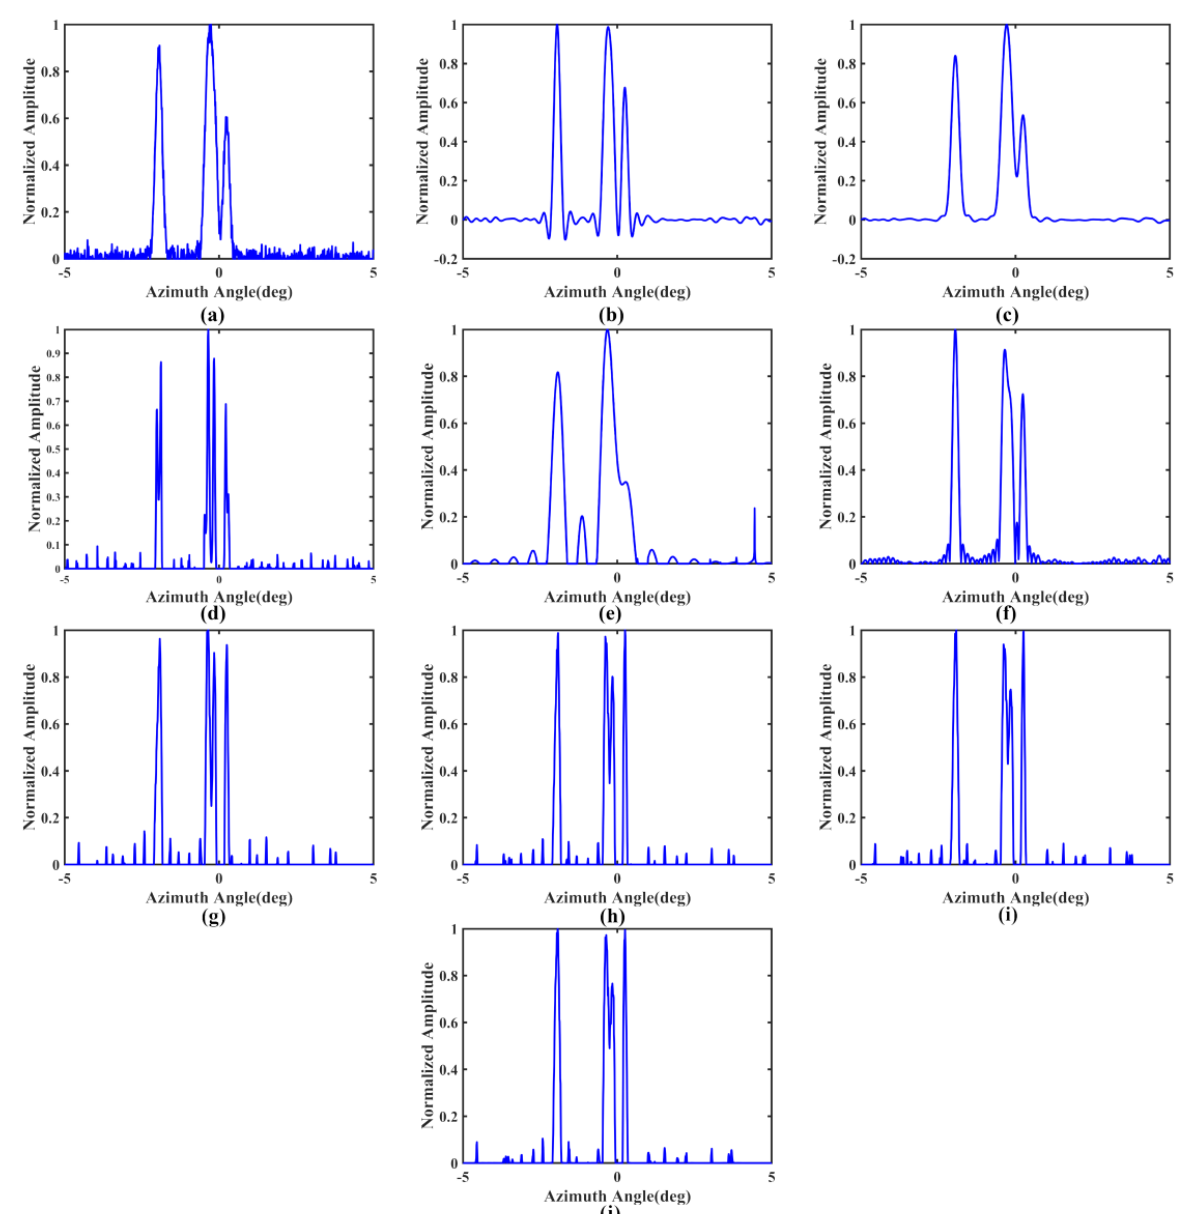
Figure 6. Restoration results of experimental scenes for visualization extracted from 500 simulations when SNR = 21 dB. ( a ) Blind deconvolution; ( b ) Regularized method; ( c ) Wiener Filter; ( d ) Richardson– Lucy method; ( e ) TSVD method; ( f ) SDBSM; (g) TV; ( h ) TVBC; ( i ) TVS; ( j ) TVSBC.